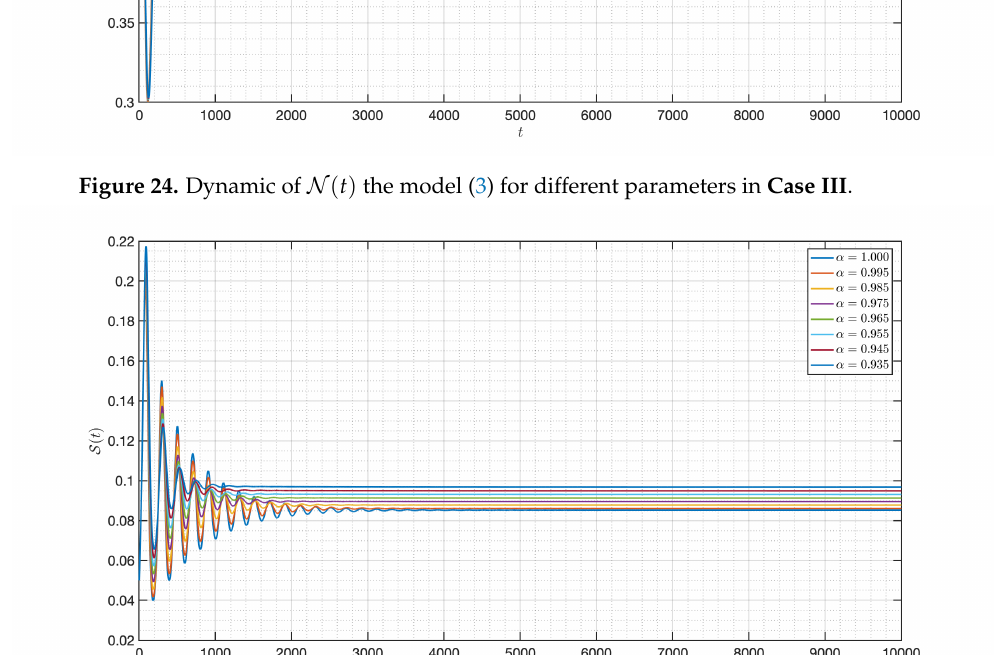
Figure 25. Dynamic of S ( t ) the model (3) for different parameters in Case III